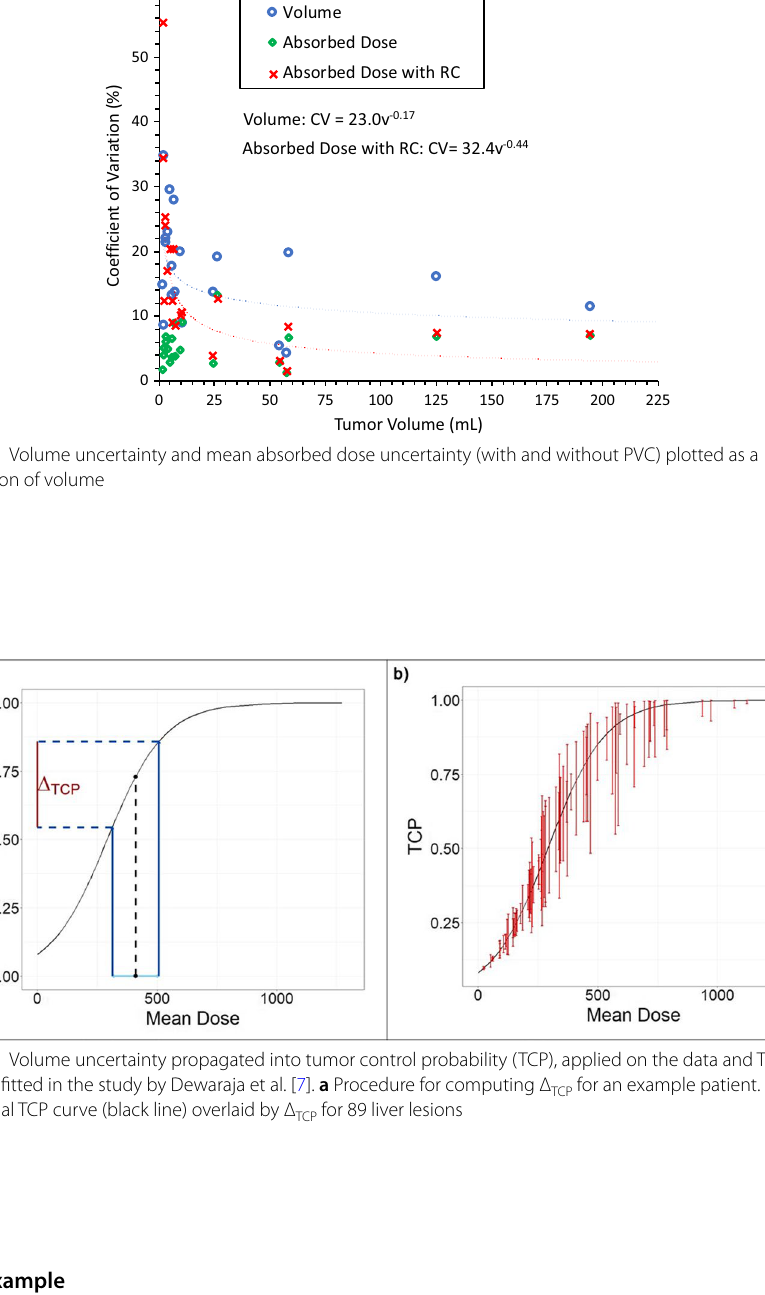
Figure 5 illustrates the propagation of volume and mean dose uncertainty into TCP. Panel A presents the procedure for finding Δ TCP for an example patient, represented by the red bar along the y-axis. Repeating the same procedure, we overlay the Δ TCP values for all 89 lesions in Panel B. Recall that the length of the bars is determined by the volume/uncertainty rela - tionship; thus, even two lesions with similar mean dose can have error bars of noticeably different sizes if their volumes differ. Among the lesions included, mean Δ TCP was 16.2% and maximum Δ TCP was 48.5%, with 27.0% of lesions having a TCP difference of at least 25% when accounting for standard uncertainty.